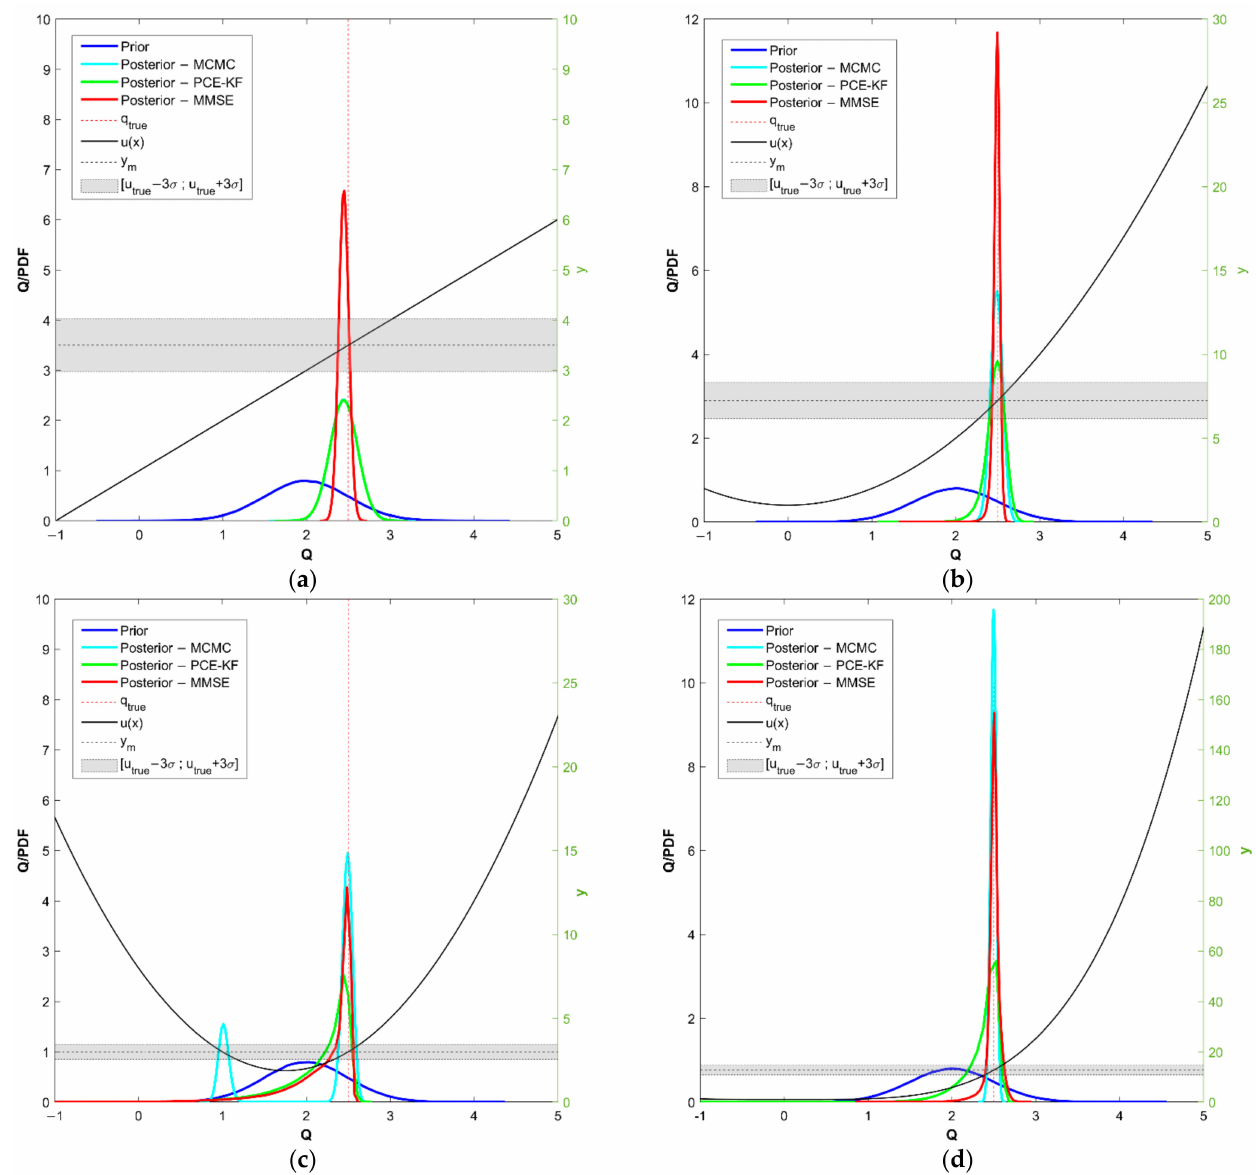
Figure 1. Comparison of different updating methods considering q true = µ + σ : ( a ) Model 1, ( b ) Model 2a, ( c ) Model 2b and ( d ) Model 3. In each figure, the following are reported: the prior PDF (in blue); the posterior PDFs obtained via MCMC (in cyan), via PCE-KF (in green) and via NL-MMSE (red solid line); the true value of the parameter q true (red dashed line); the model response u ( q ) (black solid line); the measurement y m (black dashed line); the ± 3 σ ε region of the measurement (grey